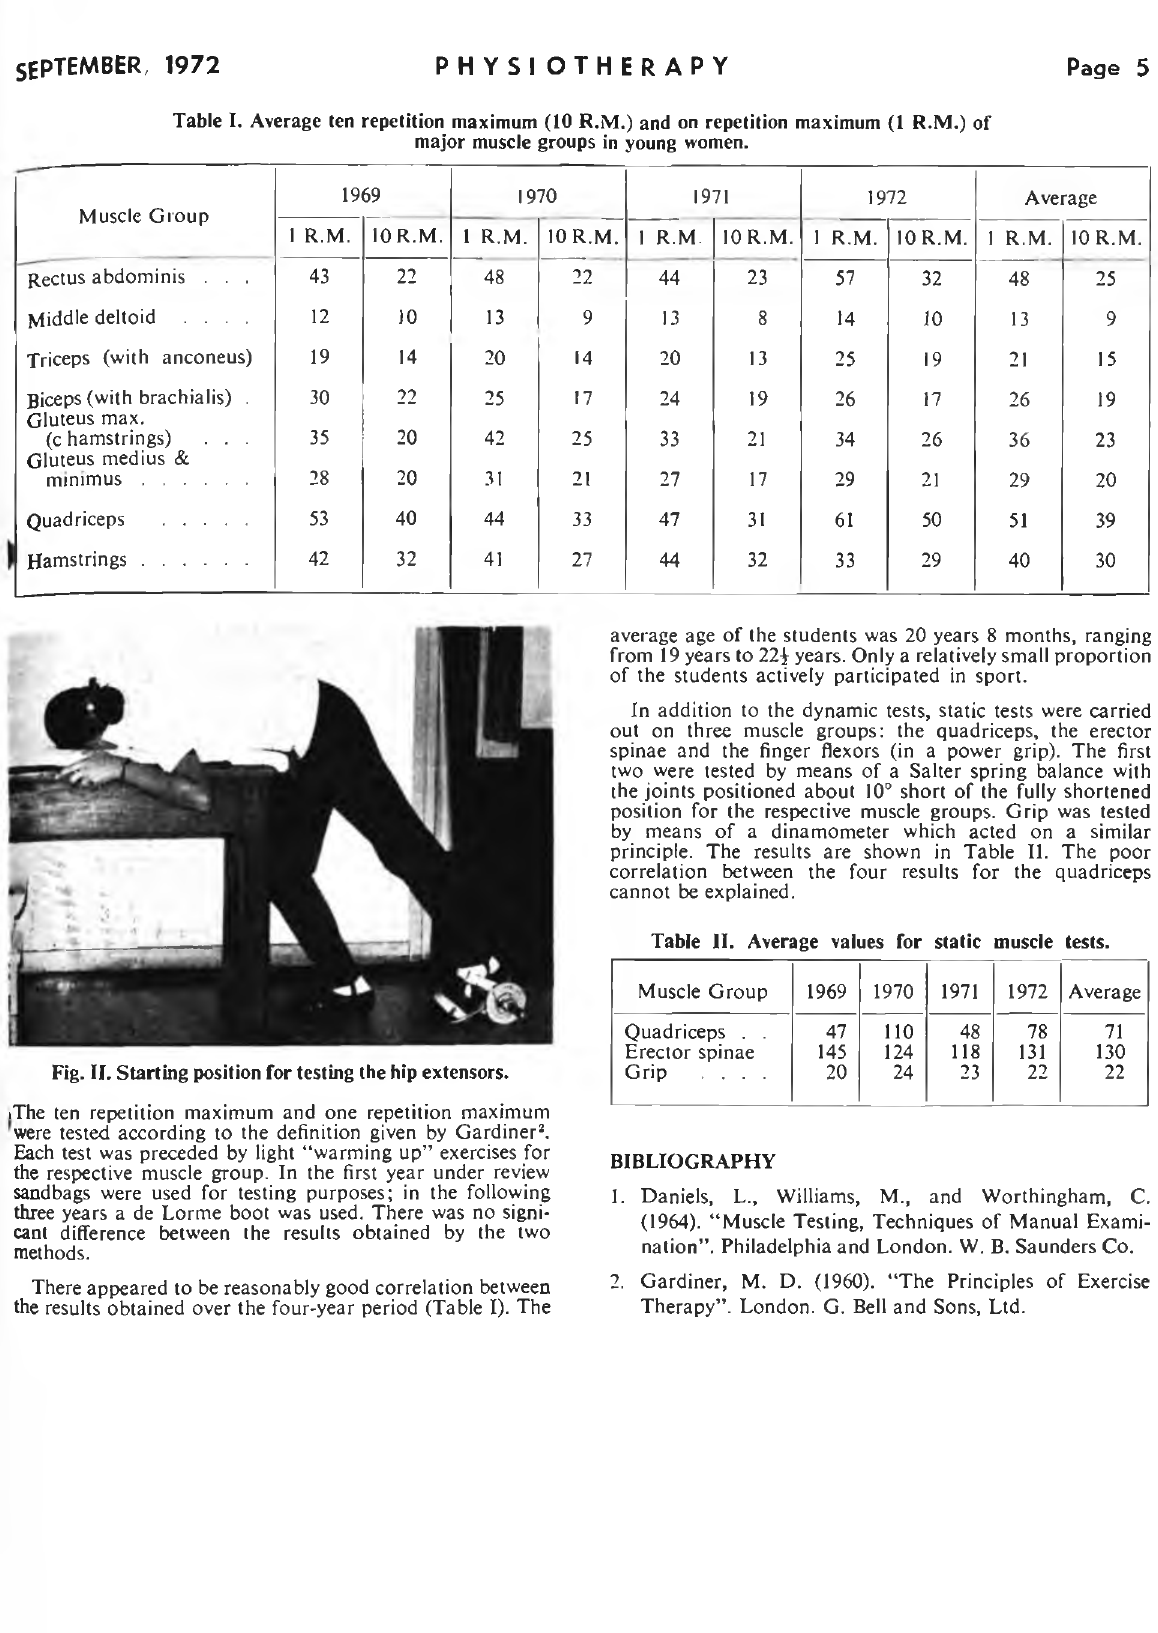
Table I. Average ten repetition maximum (10 R.M.) and on repetition maximum (1 R.M.) of major muscle groups in young women.